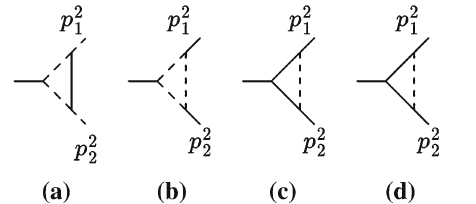
Fig. 10 One loop Sudakov integrals in limits (a)–(d). The solid and dashed lines represent respectively the massive and the mass-less par-